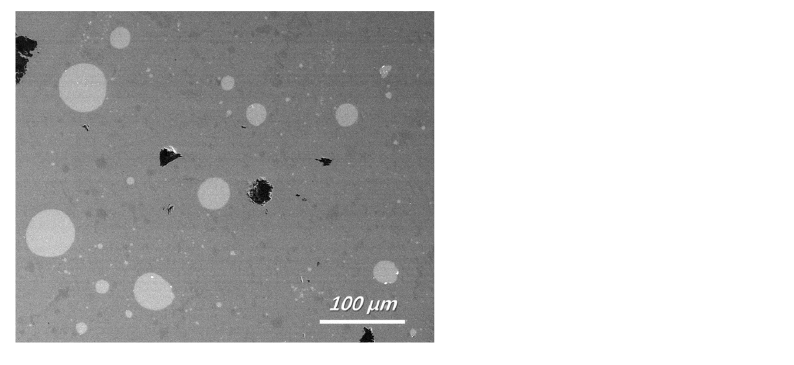
Figure 2. Feature of quenched slag near the silicon-slag interface (backscattered electron image, No. 1 slag with a refining time of 5 min). Table 4. Size distribution of silicon droplets/mm 2 .